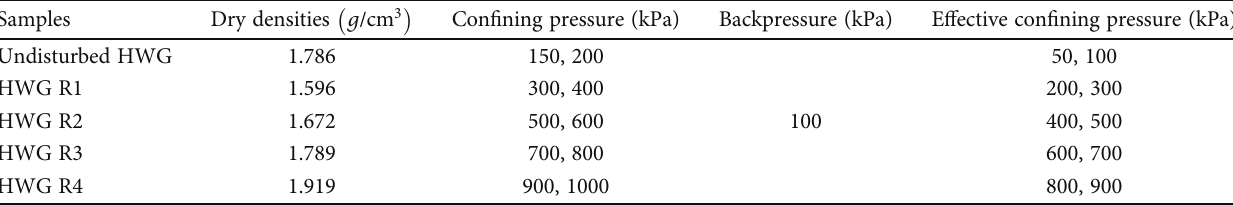
Figure 2: (a) The undisturbed HWG sample; (b) the remolded HWG sample. (Figure 2(a) from Wang et al. [26] Figure 5(a)). Table 2: Experimental schemes of